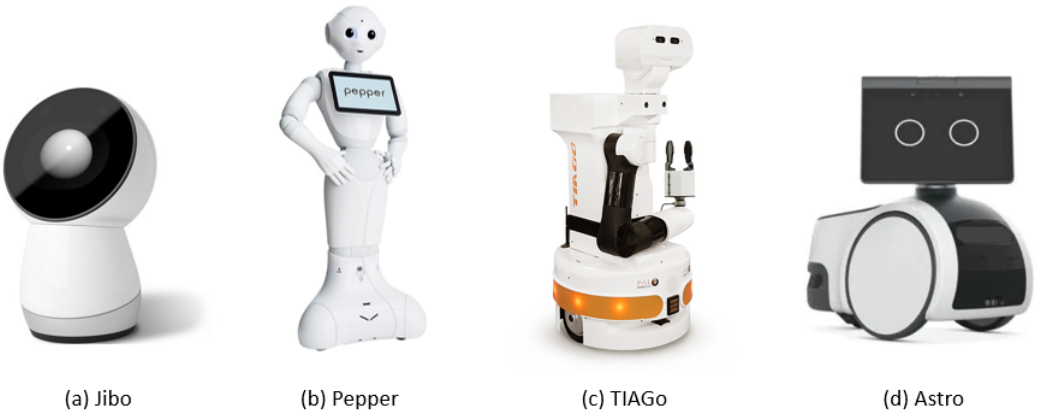
Figure 1. Commercial robots developed or suitable for service home-care